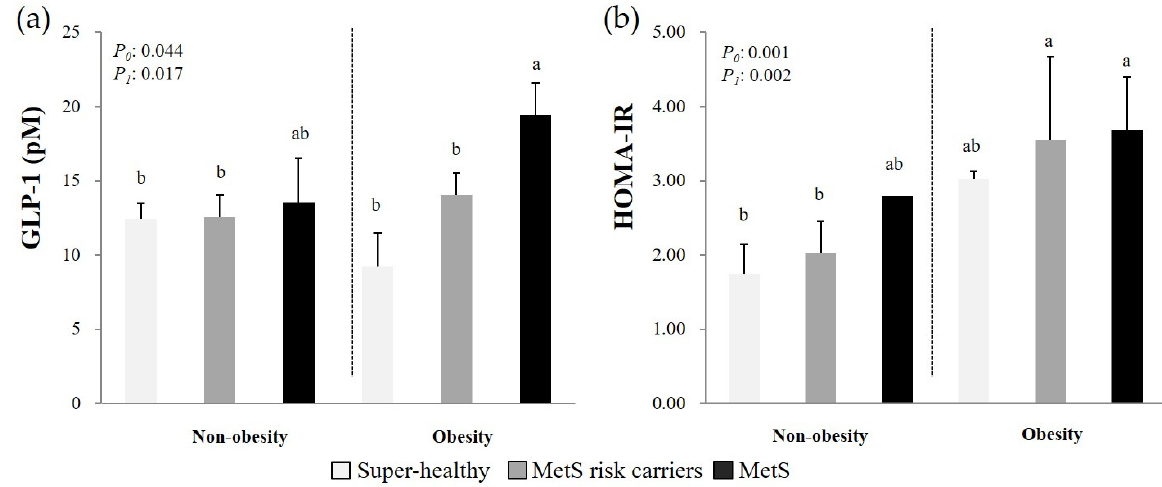
Figure 3. Circulating GLP-1 levels ( a ) and HOMA-IR scores ( b ) according to the combination of obesity and MetS status. Mean ± SD, tested after log transformation of the data; tested by the one-way analysis of variance with the Bonferroni method and with the general linear model with LSD after adjustment for confounding factors (age, total calorie intake, cigarette smoking, alcohol drinking, and menopausal status); P 0 : Unadjusted p -value, P 1 : P -value adjusted for confounding factors. Values sharing the same alphabet indicate no statistically significant differences among them. GLP-1: Glucagon-like peptide-1; HOMA-IR: Homeostatic model assessment of insulin resistance; MetS: Metabolic syndrome. Non-obesity group: Super-healthy, n = 57; MetS risk carriers, n = 31; and MetS, n = 2. Obesity group: Super-healthy, n = 4; MetS risk carriers, n = 29; and MetS, n = 17.